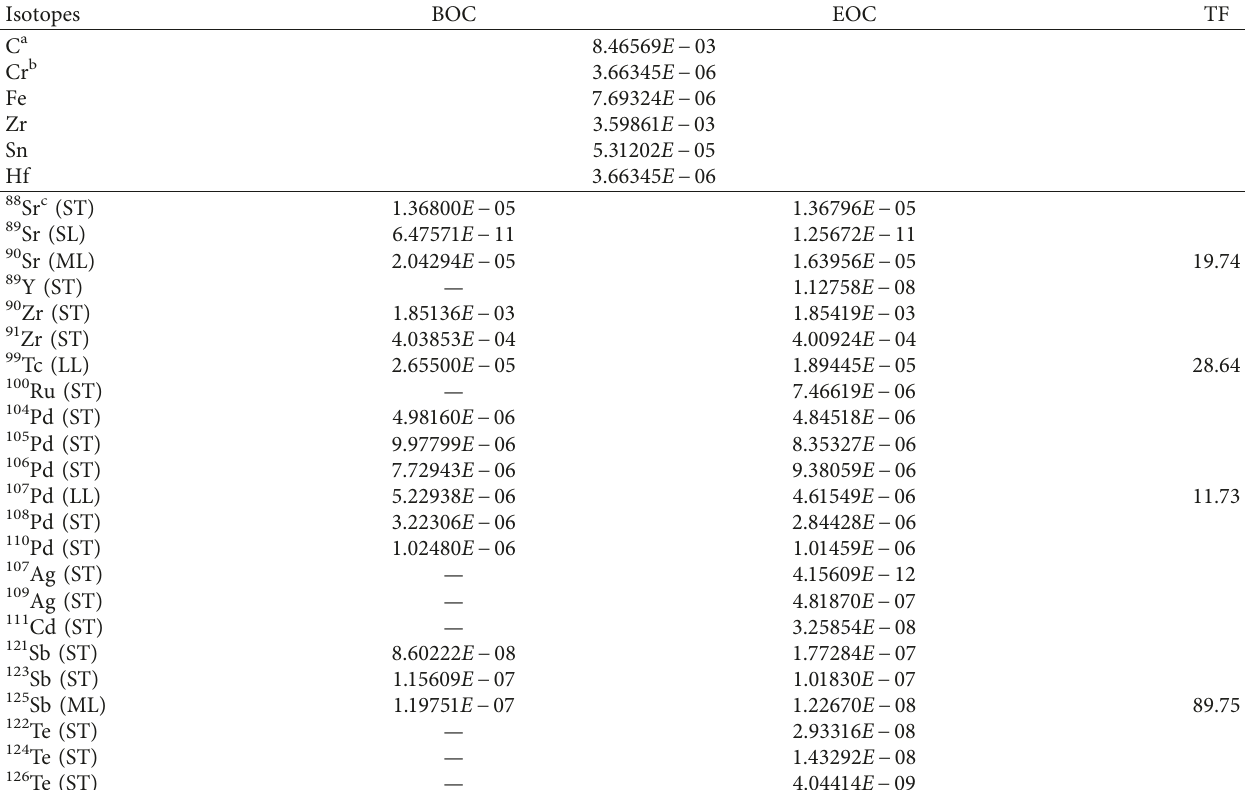
Table 3: Atomic densities of fission products in the spent fuel case of B (atoms/(barn · cm)) and transmutation fractions (%). Isotopes BOC C